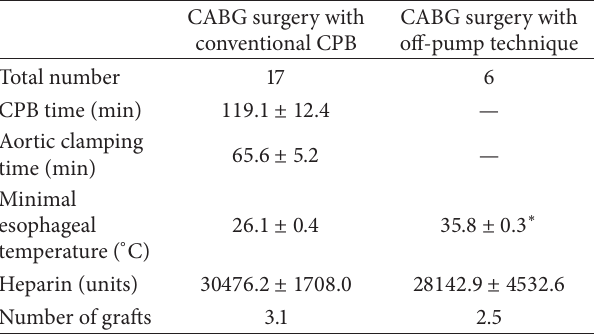
Table 2: Perioperative characteristics in CABG surgery patients. CABG surgery with CABG surgery